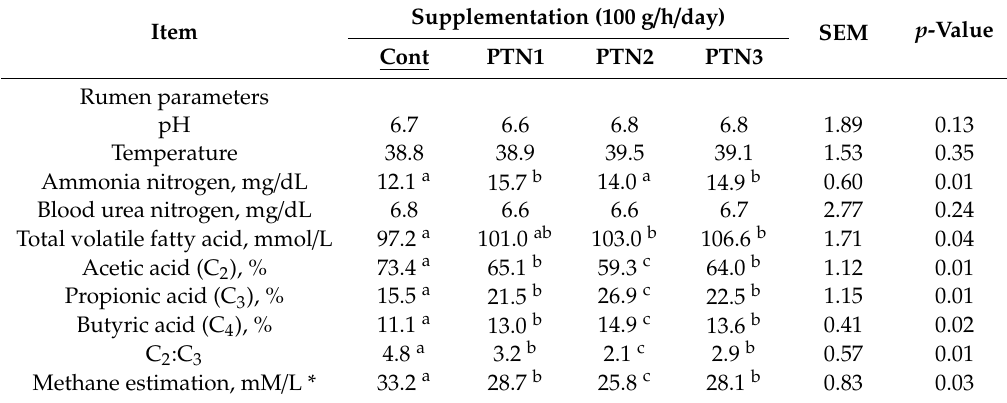
Table 3. E ff ects of some sources of phytonutrients (PTN) on the ruminal pH, temperature, ammonia nitrogen (NH 3 –N), blood urea nitrogen (BUN), and volatile fatty acid concentrations in swamp bu ff aloes.